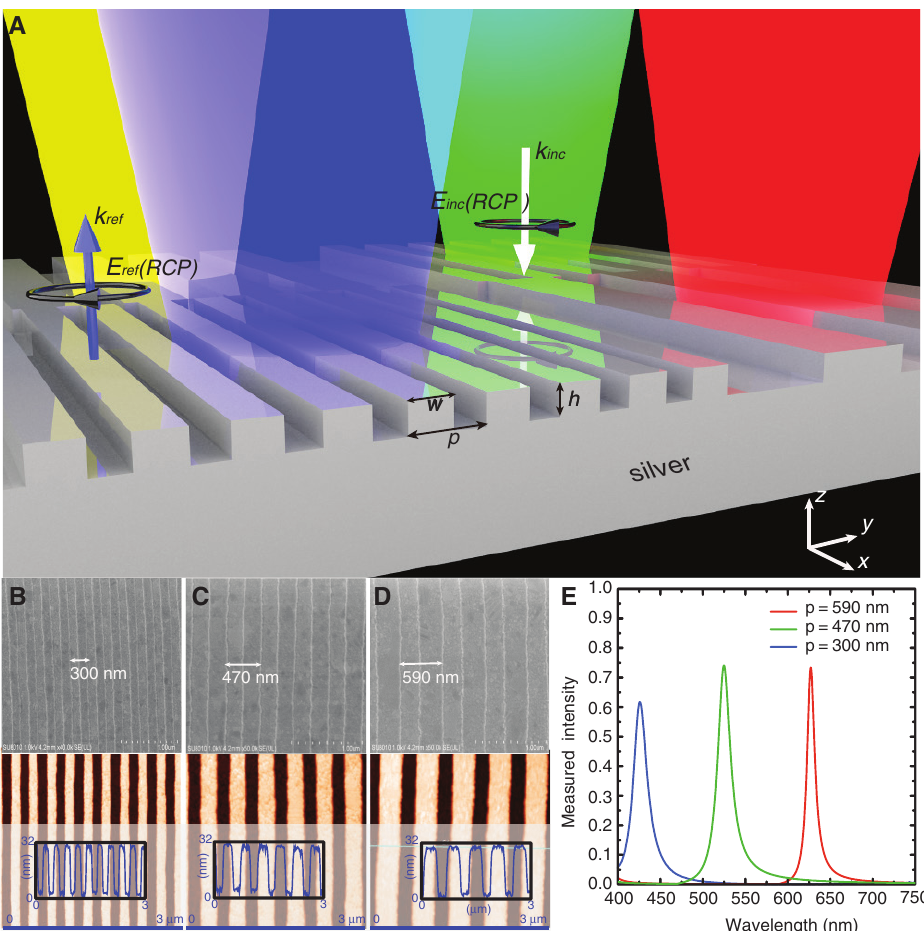
Figure 1: High-performance structural color filters formed by plasmonic metamirror. (A) Schematic diagram of the light-structure interac- tion. White and blue arrows indicate the incident and reflective right-handed CP light. Black arrows depict the spin state of the incident and reflective waves. Red, yellow, green, and blue beams represent the reflected waves with restored spin states. The duty cycle ( w / p ) is fixed to be 0.55. (B–D) SEM and AFM images of the prepared filters with periods of 300, 470, and 590 nm. The samples exhibit uniform line width, high fidelity, and smooth surface morphology. (E) Experimentally measured reflection spectra of the cross-polarized scattered light for 45 ° polarized LP at normal